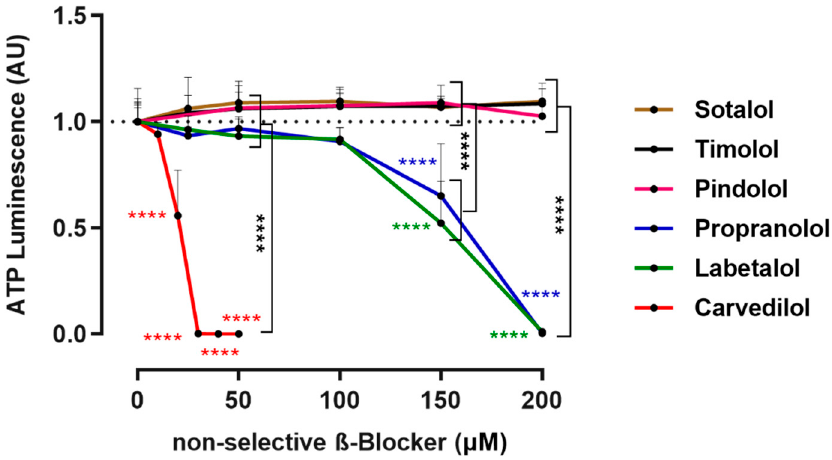
Figure 1. Screening of non-selective ß-blockers for anti-tumor properties in 3D tumor spheroids. Spheroids were generated from a Mel270 cell line and treated with the respective non-selective ß-blocker at the indicated concentration. After 7 days of incubation, spheroid viability was assayed with an ATP luminescence assay. The ATP luminescence of the treated spheroids was normalized to the ATP luminescence of the control spheroids (0 µ M ß-blocker) and is given in arbitrary units (AU). Representative results from at least 3 independent experiments for each ß-blocker are shown. The means +/ − SD of n = 8 spheroids for each condition are shown. Statistical analysis by two-way ANOVA and Tukey’s multiple comparisons test, and the significance levels of the treated spheroids in relation to the control spheroids (0 µ M ß-blocker) are displayed in color. Significance levels are indicated at **** p <